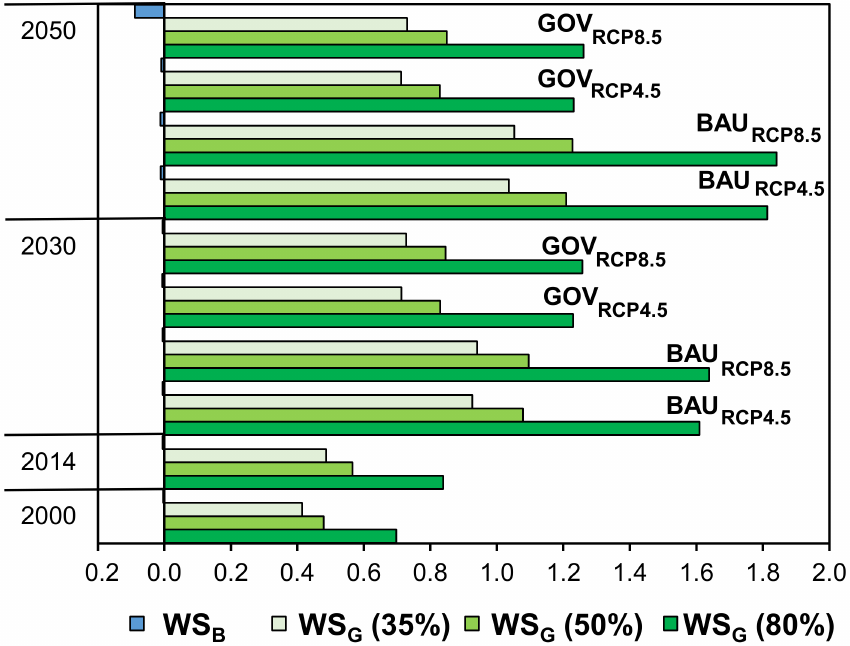
Figure 4. Annual blue (WS B ) and green (WS G ) water scarcities for the Xingu Basin of Mato Grosso in 2000 and 2014 hydrologic years, business-as-usual (BAU) and governance (GOV) deforestation scenarios considering Representative Concentration Pathways (RCP 4.5 and 8.5 W m − 2 ) (Table 1). Values of WS G were obtained assuming that 35%, 50%, and 80% natural vegetation cover in the basin was maintained as described in the